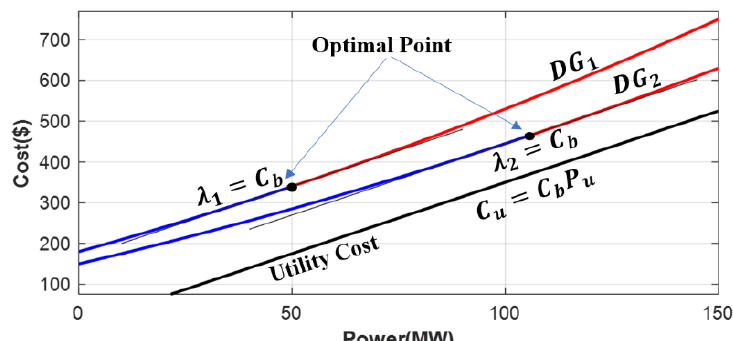
Figure 2. Cost of the utility and two typical generators. 𝜆 1 shows the point that the incremental cost of DDG1 equals the utility rate. 𝜆 2 shows the point that the incremental cost of DDG2 equals the utility rate. At the optimum point, 𝜆 1 = 𝜆 2 = 𝐶 𝑏 .